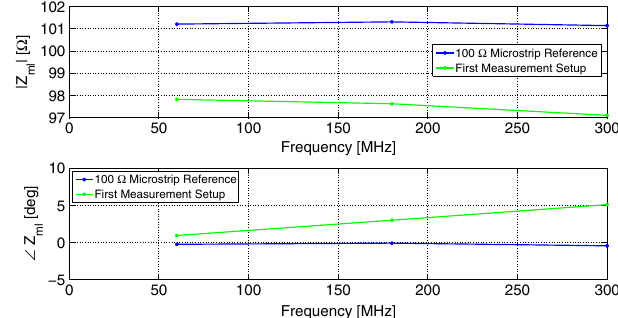
=c for the frequencies where (cid:1) ml L ml ¼ FIG. 20. (cid:5) ml L ml and v g FIG. 21. Electromagnetic simulations of the 100 (cid:1) straight (cid:2) ð 2 k þ 1 Þ = 2 ; c is the light velocity in vacuum. Comparison microstrip line, 500 mm long: modulus and phase of the Z ml between the measurements performed with the two different for the frequencies where (cid:1) ml L ml ¼ (cid:2) ð 2 k þ 1 Þ = 2 ; comparison setups: (A) first setup; (B) second setup. between the simulated reference, and the case with the coaxial- microstrip transitions of the first measurements setup , shown in Fig.